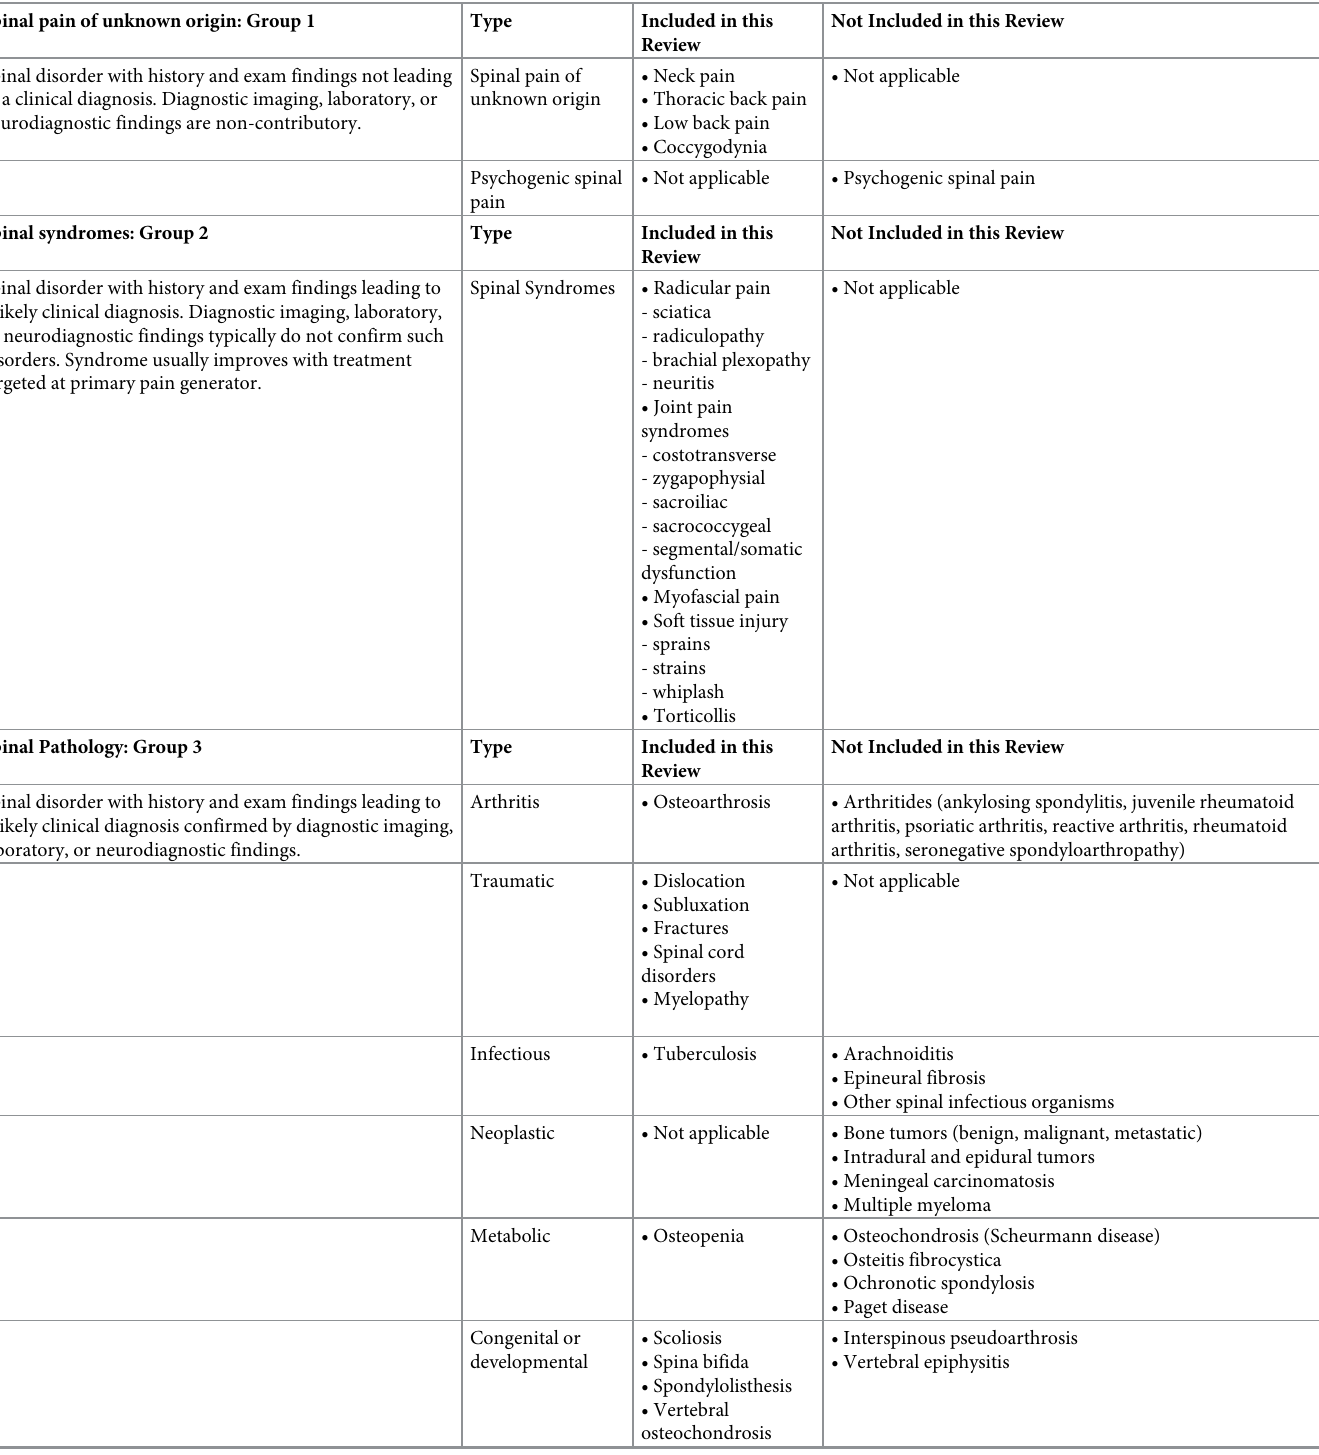
Table 1. Disorders considered in case definition of common spinal disorders; inclusion and exclusion